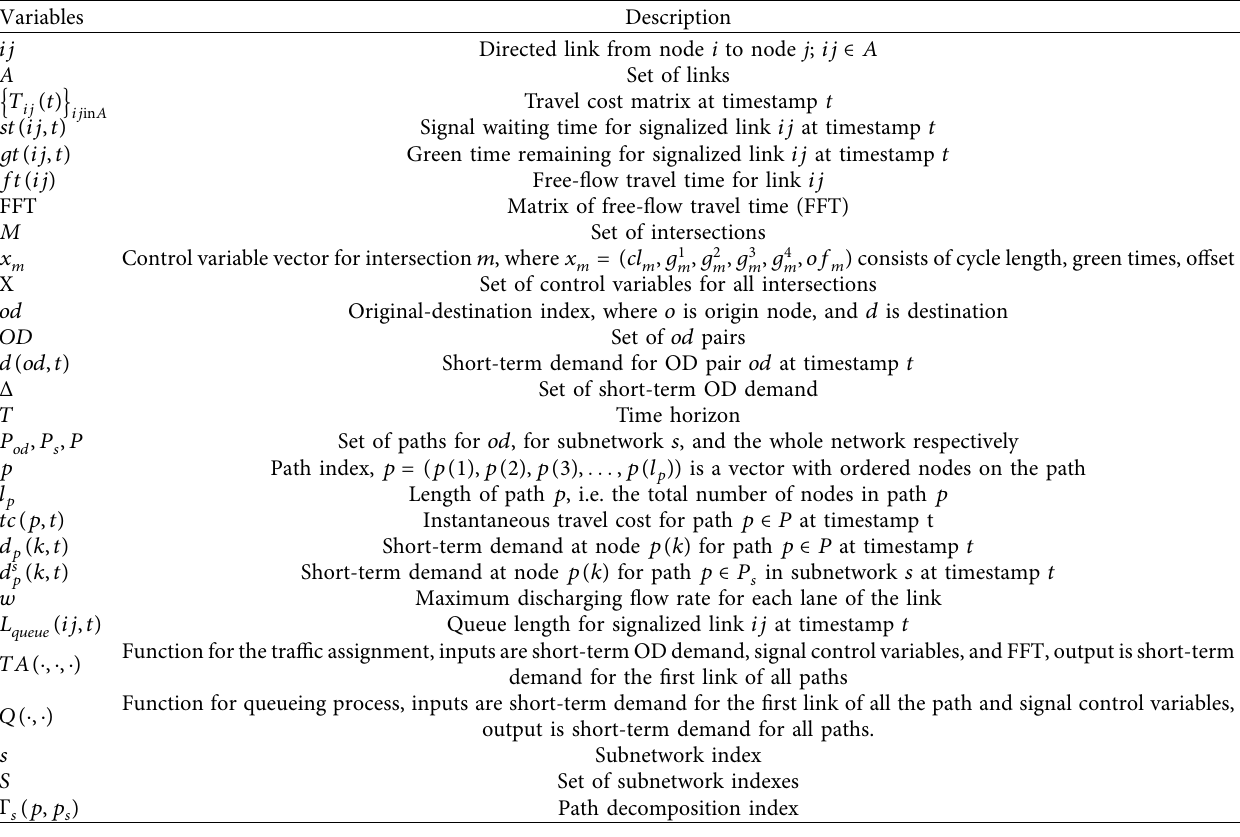
Table 2: Notation and variables.